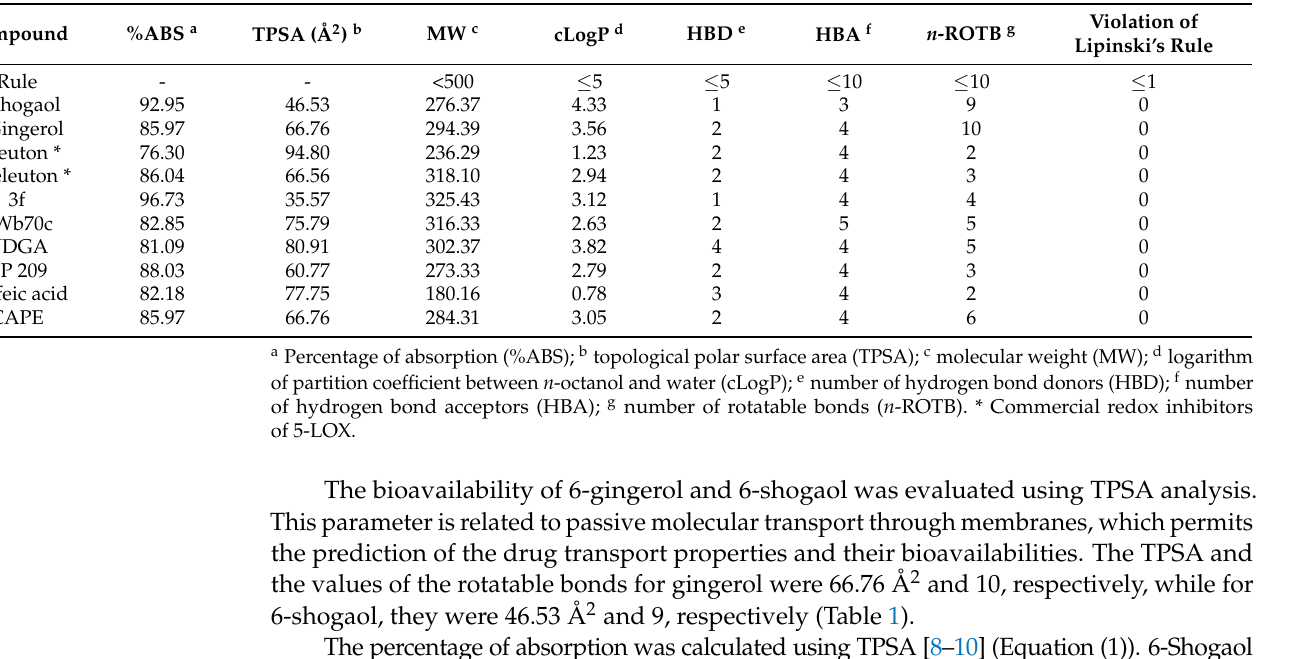
Table 1. Pharmacokinetic properties of 6-shogaol and 6-gingerol compared with redox inhibitors of 5-LOX obtained from Osiris Data Warrior and Molinspiration